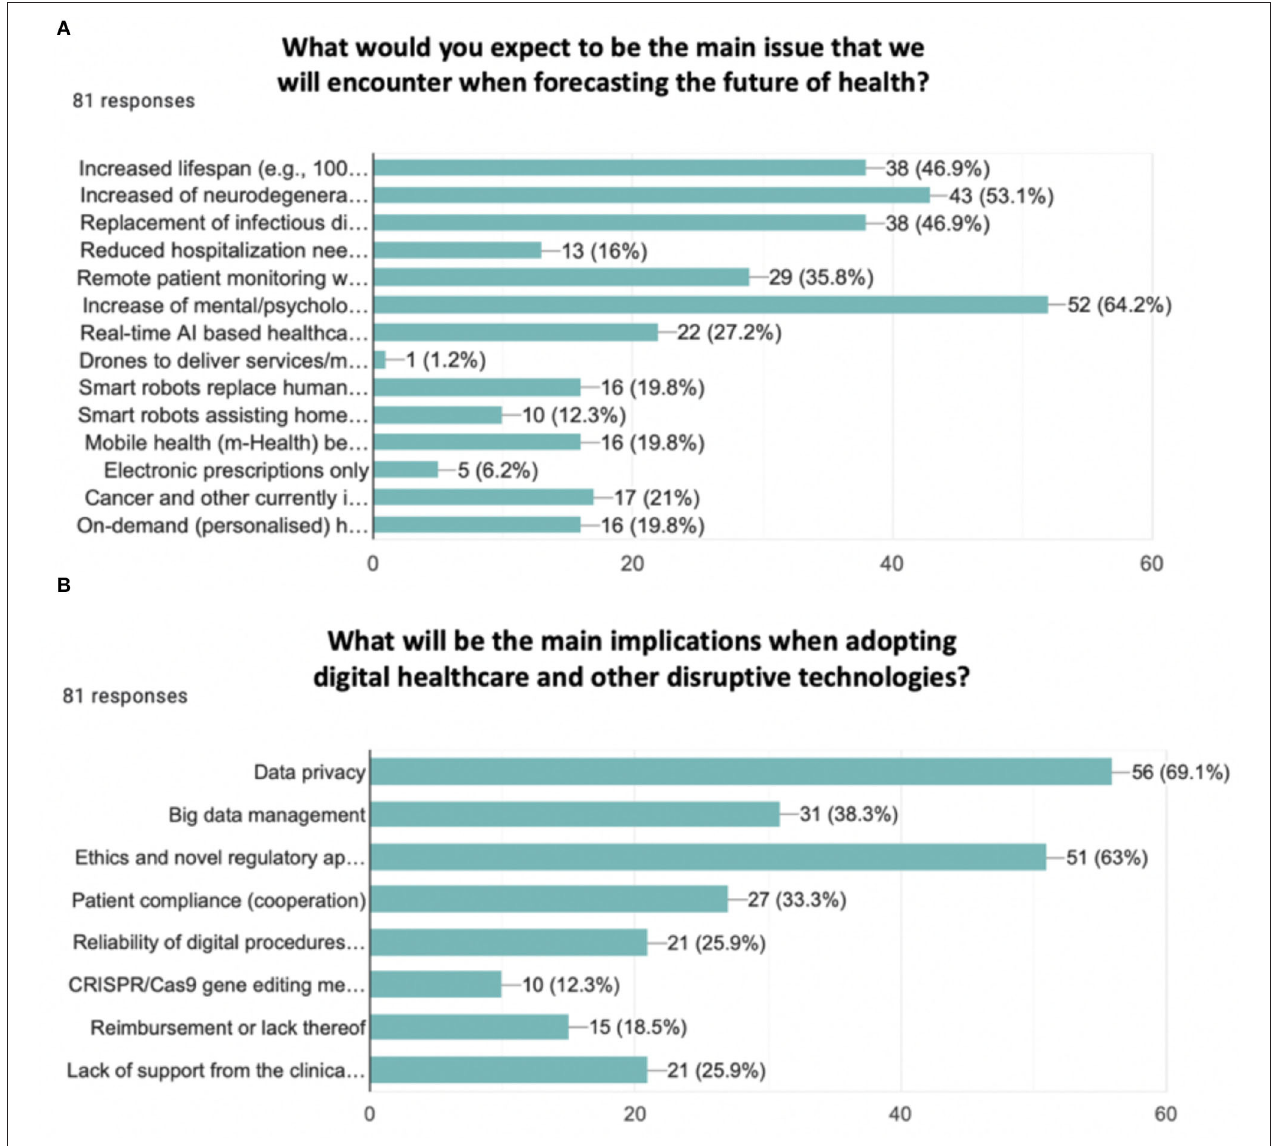
FIGURE 4 | Bar chart. (A) What would you expect to be the main issue that we will encounter when forecasting the future of health? Options were: increased lifespan (e.g., 100 years of life perspective), increased of neurodegenerative disorders (e.g., Alzheimer’s disease and other dementias), replacement of infectious diseases with increased chronic diseases (e.g., cardiovascular, pulmonary disease, type 2 diabetes, osteoporosis, arthritis, cancer), reduced hospitalization needs and nursing assistance, remote patient monitoring with digital healthcare systems (e.g., visiting the doctor in person will become a privilege), increase of mental/psychological illnesses, real-time AI-based healthcare home assistance, drones to deliver services/medical products (e.g., especially in undeveloped areas), smart robots replace humans at the hospital/pharmacy/medical ambulatory reception, smart robots assisting home care, mobile health (m-Health) becomes the standard of operations/procedures/services, electronic prescriptions only, cancer and other currently incurable diseases can be treated with pills or injections, on-demand (personalized) healthcare services. The most five selected responses were: increased lifespan (46.9%), increased of neurodegenerative disorders (53.1%), replacement of infectious diseases with increased chronic diseases (46.9%), remote patient monitoring with digital healthcare systems (35.8%), and increase of mental/psychological illnesses (64.2%). (B) What will be the main implications when adopting digital healthcare and other disruptive technologies? Options were: data privacy, big data management, ethics, and novel regulatory approvals, patient compliance (cooperation), reliability of digital procedures and clouds (e.g., to acquire, process, store, and exchange data), CRISPR/Cas9 gene-editing method, reimbursement or lack thereof, lack of support from the clinical profession. The most three selected responses were data privacy (69.1%), big data management (38.3%), and ethics and novel regulatory approvals (63%).